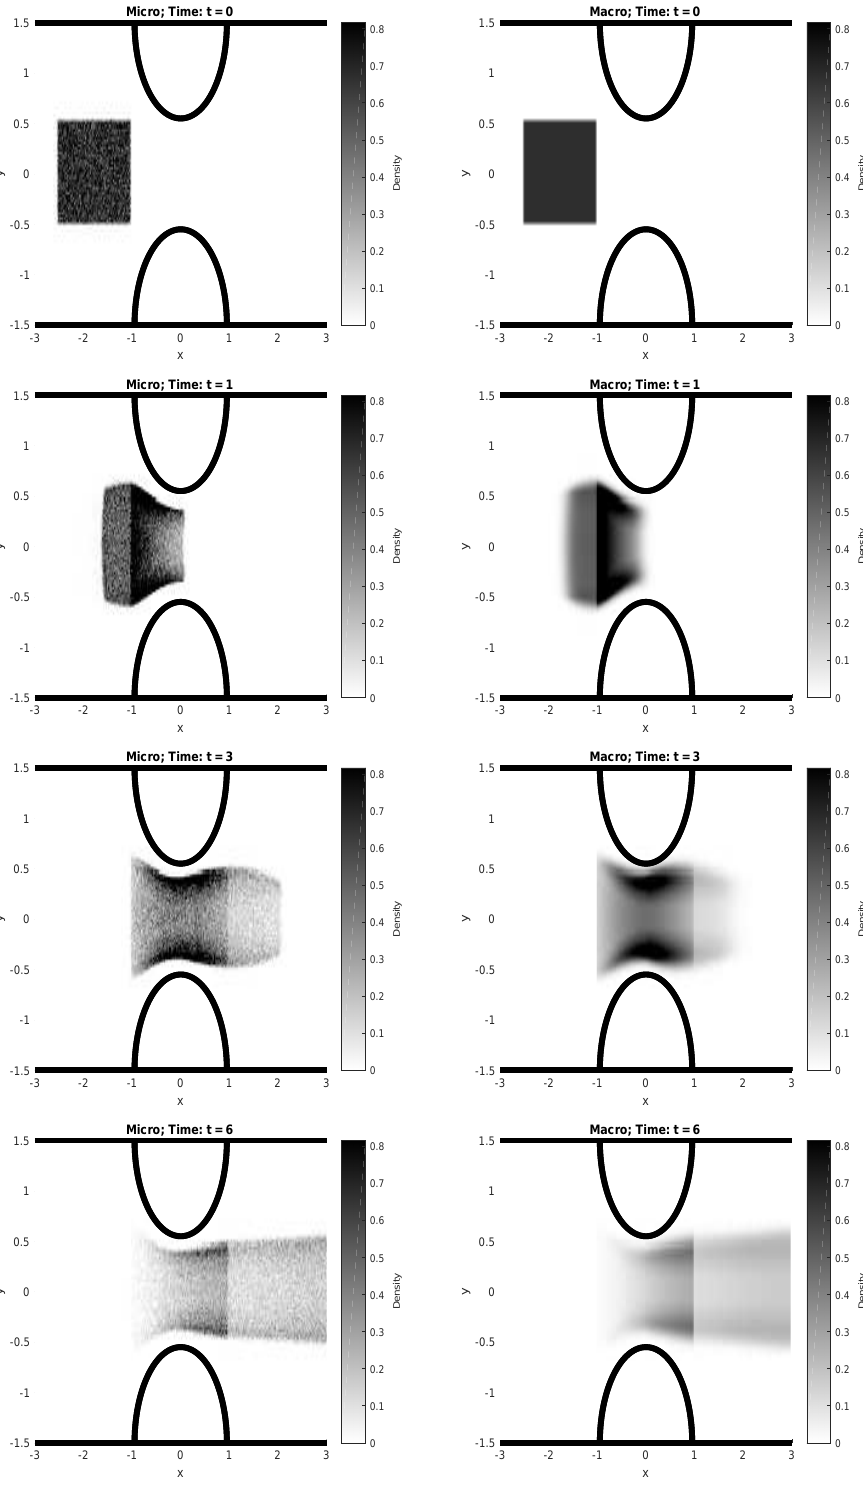
Figure 7: Densities for λ 1 at different